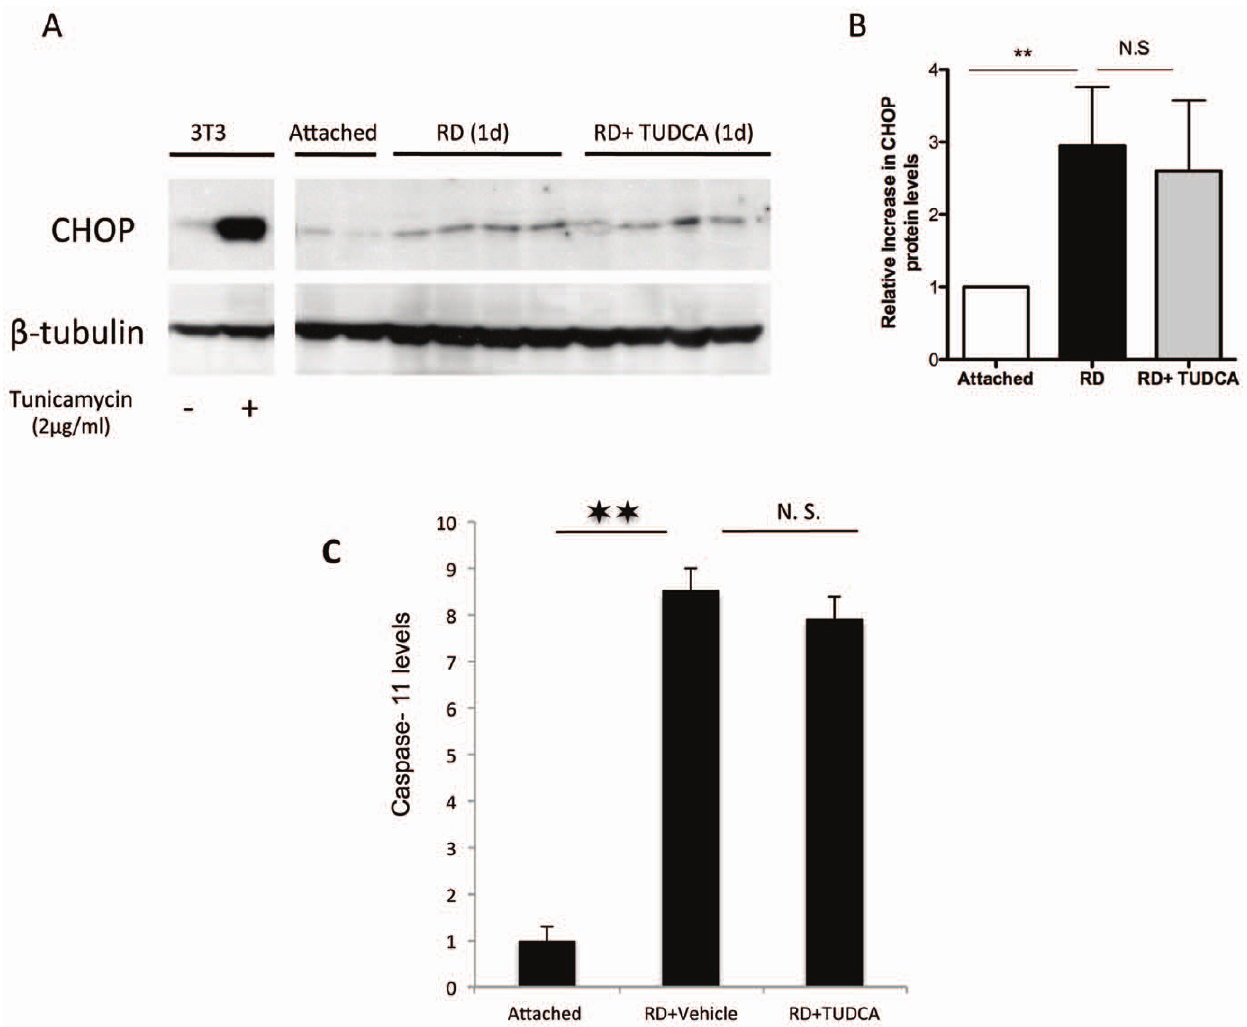
Figure 5. TUDCA treatment does not affect endoplasmic reticulum stress and Caspase 11 levels induced by RD. Western blots ( A ) and quantification ( B ) of CHOP expression in retinal lysates from attached and detached retinas treated with TUDCA or vehicle (administered as in figure 1). (n=4 p , 0.05 for RD vs attached). 3T3 fibroblasts and Tunicamycin (2microgram/ml for 6 hours) were used as a positive control. ( C ) Quantification of Caspase 11 levels after RD and TUDCA treatment (n=6, p .